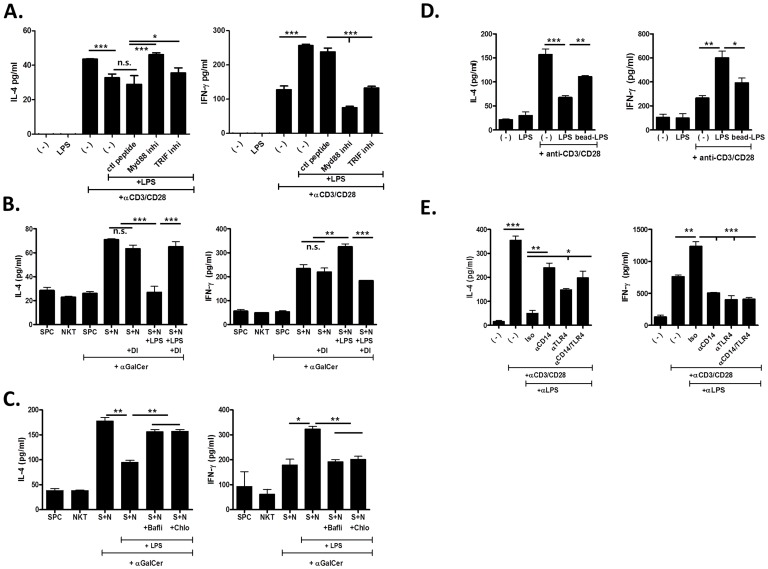
TLR4-mediated cytokine modulation by iNKT cells is triggered by MyD88 and TRIF, and depends on endocytosis and formation of the endosome compartment.(A, D, E) Sorted iNKT cells were incubated with anti-CD3+ CD28 mAbs or anti-CD3+ CD28 mAbs + LPS in RPMI media for 24 h. The concentration of IL-4 and IFN-γ was measured in culture supernatant by ELISA. (A) To block TLR4 signals, iNKT cells were pre-treated with Myd88 or TRIF inhibitor, or control (ctl) peptide for 1 h. iNKT cells (NKT or N), preincubated with 100 µM/ml of dynamin inhibitor (DI) (B), 100 nM/ml of bafiliomycin A1 (Bafli) for 30 min or 100 µM/ml of chloroquine (Chlo) for 2 h (C), were incubated with irradiated splenocytes (SPC or S) in the presence of α-GalCer. (D) iNKT cells were incubated with agarose bead-bound or unbound LPS in the presence of anti-CD3 and CD28 mAbs. (E) To inhibit surface TLR4 and/or CD14, iNKT cells were preincubated with anti-TLR4 mAb (25 µg/ml) or anti-CD14 mAb (50 µg/ml) for 30 min at 4°C before anti-CD3+ CD28 mAb stimulation. Data are representative of three independent observations. (n = 3 in each group; *p<0.05, **p<0.01, ***p<0.001).